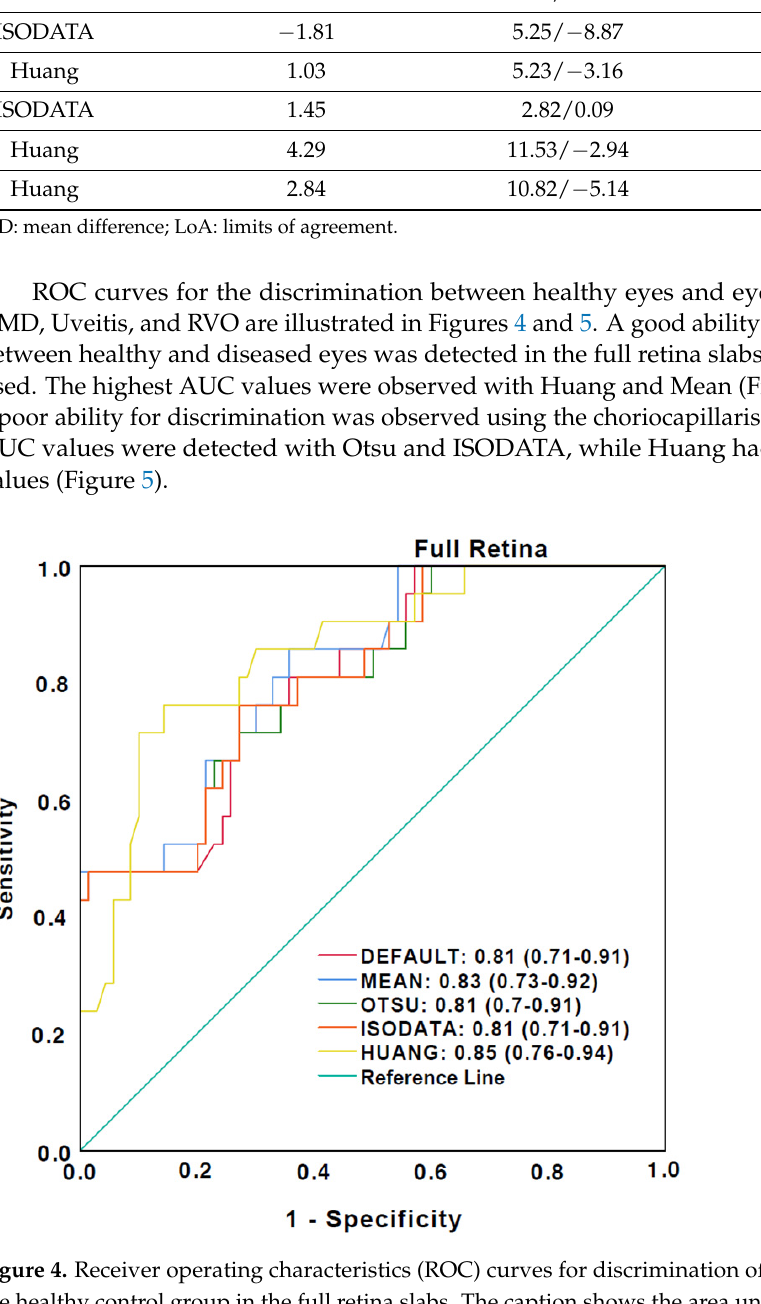
Figure 5. Receiver operating characteristics (ROC) curves for discrimination of diseased eyes from the healthy control group in the choriocapillaris slabs. The caption shows the area under the curve (AUC) values and the 95% confidence interval. 4. Discussion In the present study, we compared five different automated thresholding algorithms to calculate the VD in OCTA images of the macula in full retina and choriocapillaris angi- ograms of eyes of patients with DR, RVO, Uveitis, AMD, and healthy eyes. We applied an LD-F2-analysis, intra-algorithm reliability, inter-algorithm agreement, and ability to dis- criminate between healthy and diseased eyes in commonly used auto-threshold methods: